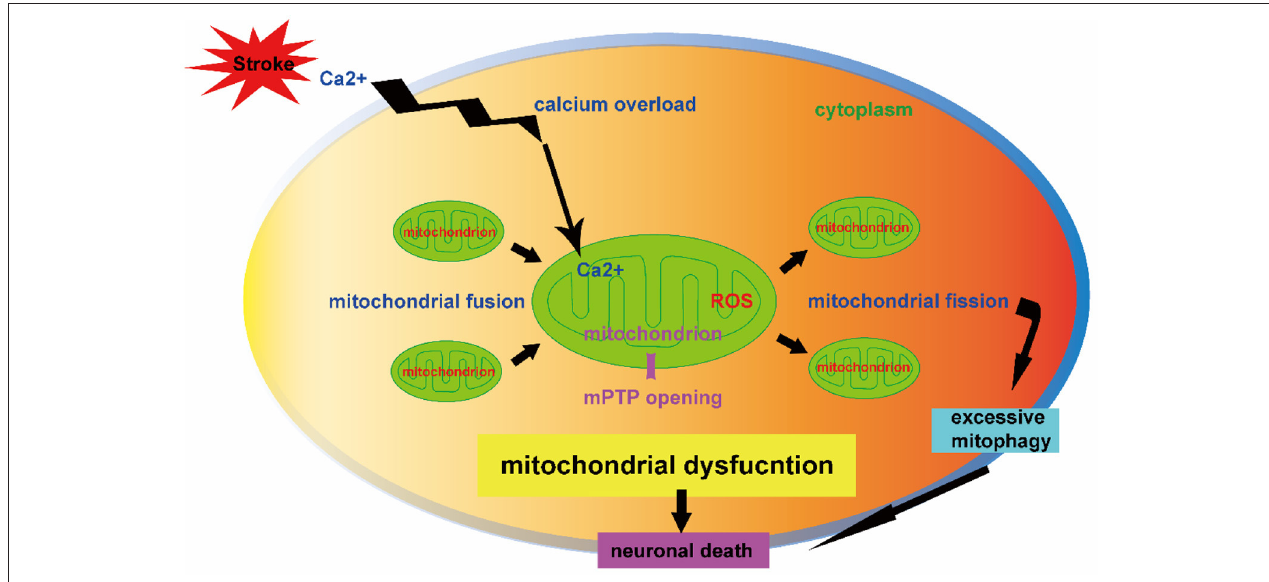
FIGURE 1 | Mitochondrial dysfunction contributing to neuronal death after stroke. The mitochondrial dynamics (fission and fusion) and mitophagy-mediated mitochondrial quality control are key mechanisms in regulation of neuron fate after stroke. The mitochondrial calcium overload, opening of mitochondrial permeability transition pore (mPTP) and over production of reactive oxygen species (ROS) impair mitochondrial dynamics. The effect of mitophagy depends on its injury severity in which overactive mitophagy is detrimental to neuronal survival. The dysregulation of mitochondrial dynamics and excessive mitophagy result in neuronal